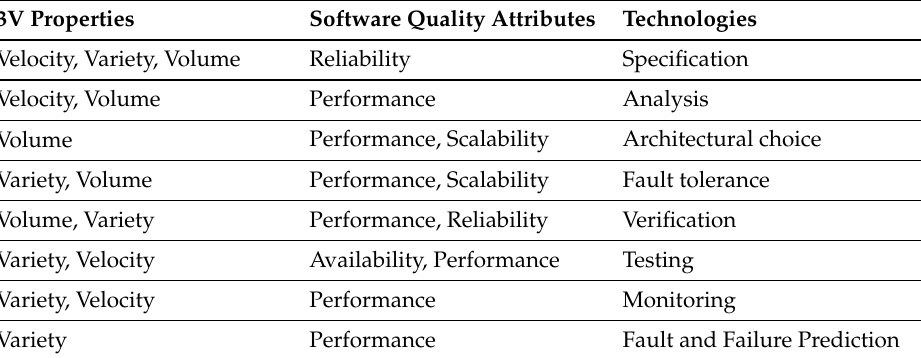
Table 14. 3V properties, quality attributes and QA